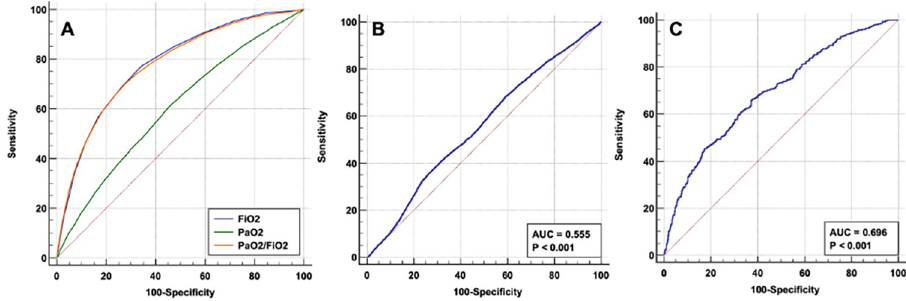
Fig 4. Blood oxygen indices operating characteristics analysis. ( A). AUC for FiO 2 , PaO 2 and PaO 2 /FiO 2 , (B). Total oxygen content (CaO 2 ), (C). Oxygen extraction ratio (O 2